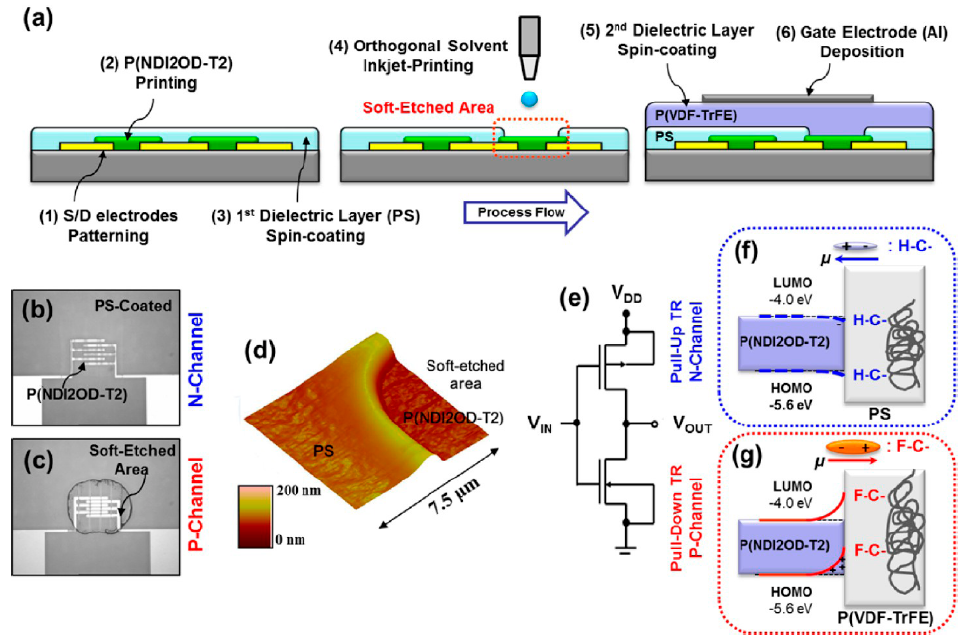
Figure 9. ( a ) Schematic diagram of the fabrication of an inverter with the inkjet-etching technique. Poly([ N , N ′ -bis(2-octyldodecyl)-naphthalene-1,4,5,8-bis(dicarboximide)-2,6-diyl]-alt-5,5 ′ -(2,2 ′ -bithiophene)) (P(NDI2OD-T2)) was used as the active layer and poly(vinylidenefluoride-trifluoroethylene) (P(VDF-TrFE)) and PS/P(VDF-TrFE) were used as dielectric layers for p-channel and n-channel transistors, respectively. Optical microscopy images of the PS-coated ( b ) and PS-etched ( c ) regions. ( d ) AFM image of a inkjet-etched PS film on a P(NDI2OD-T2) layer, showing the presence of PS microholes. ( e ) Circuit diagram of the complementary inverter. Band diagrams of the semiconductor-dielectric contact regions of the n-channel ( f ) and p-channel ( g ) transistors. Band-bending is determined by the different functional groups in the dielectrics [47]. Copyright 2013 American Chemical Society.